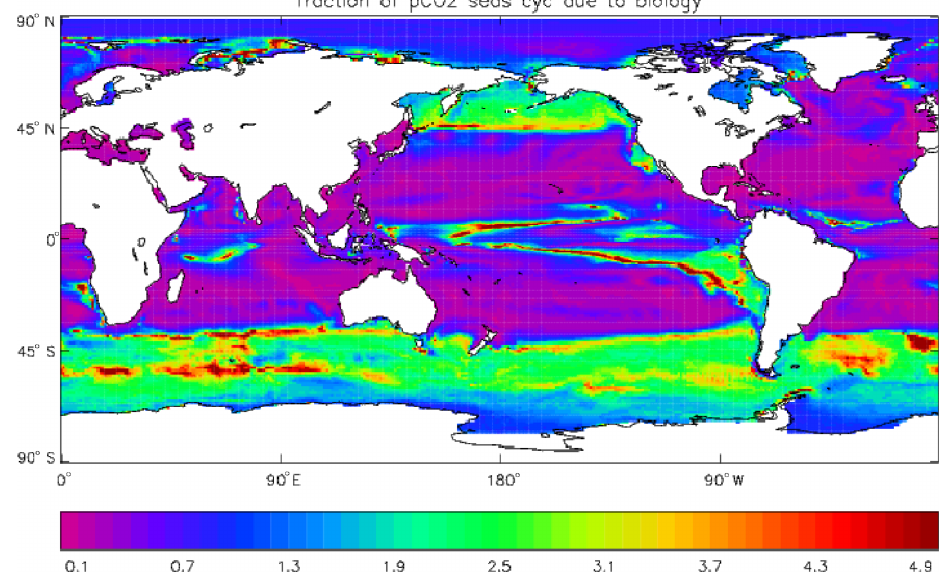
Figure 17. Fraction of the seasonal cycle of p CO 2 that is not driven by the temperature (and salinity) seasonal variation. The details of the calculation are given in the text. Where the ratio is less than 0.5, the temperature variation dominates, and where the ratio is greater than 0.5 the biological uptake and respiration (and the air–sea uptake) dominate. Ratios greater than 1.0 indicate that the biologically driven and temperature-driven cycles are